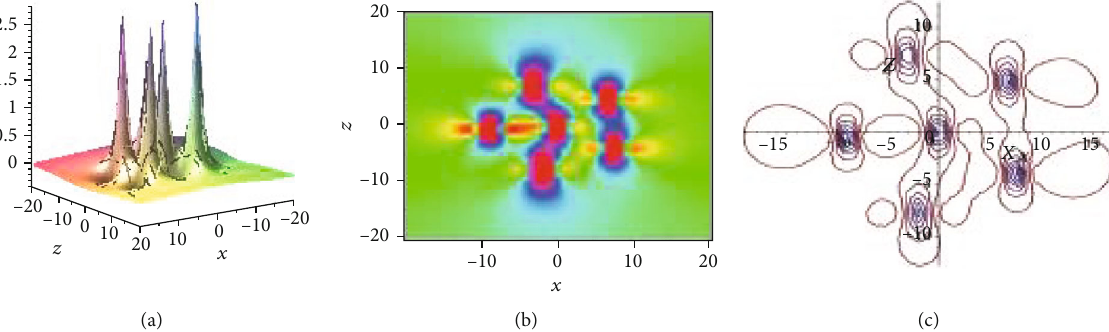
= 0, α = 80000, β = 80000 . (a) 0